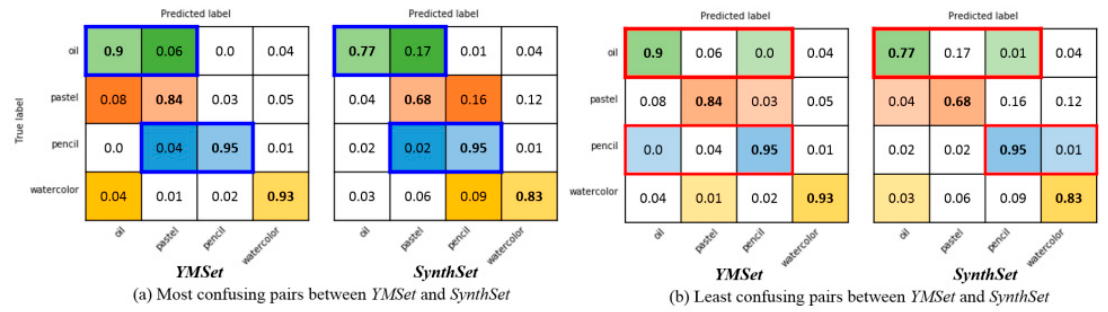
Figure 11. The most confusing pairs and least confusing pairs between YMSet ( a ) and SynthSet ( b